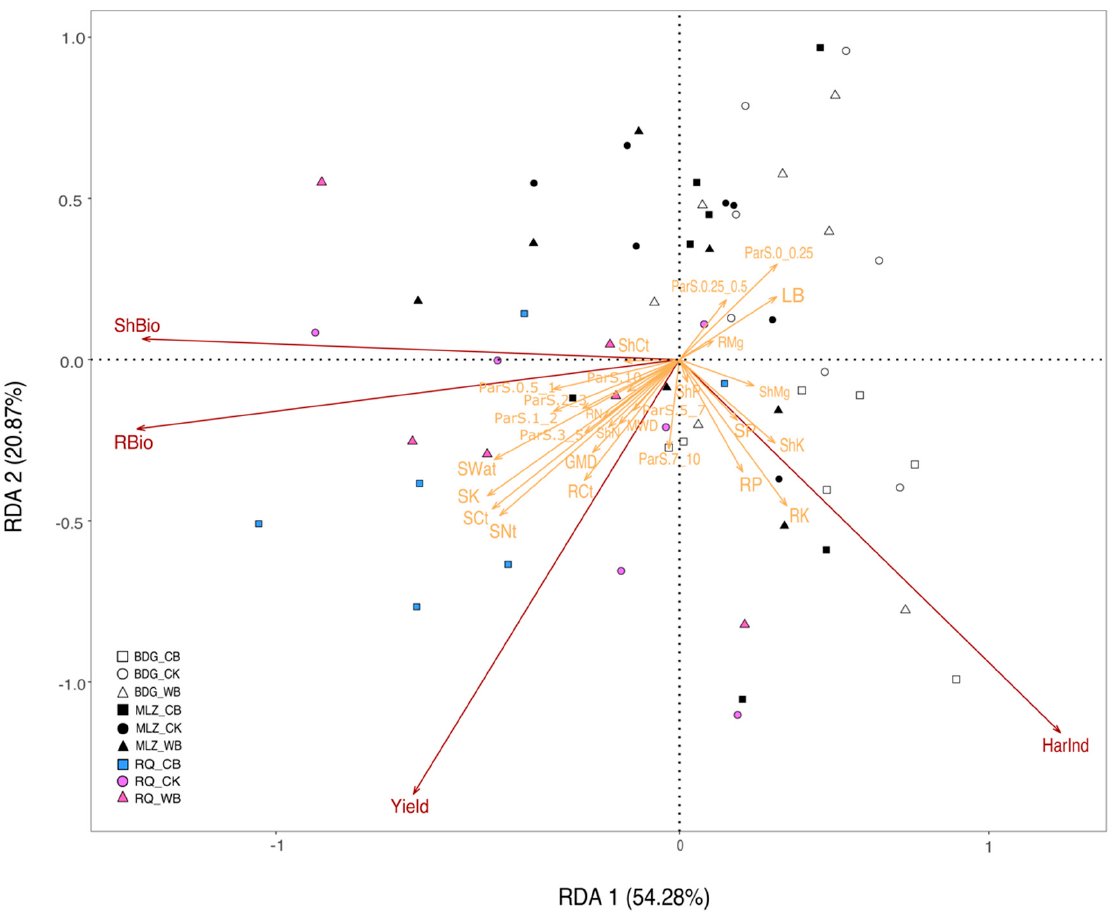
Figure 6. RDA-ordination triplot of variables in sandy clay loam (BDG and MLZ) and silty clay loam (RQ) soils. Response variables are shown in the red vector; explanatory variables are shown in the orange vector. ShBio, shoot biomass; Rbio, root biomass; Yield, grain yield; Harlnd, harvest index; LB, leghemoglobin content; SCt, soil total C content; SNt, soil total N content; SP, soil P content; SK, soil K content; Swat, soil water content; MWD, mean weight diameter; GMD, geometric mean diameter; ParS, particle size; ShCt, shoot C concentration; ShN, shoot N concentration; ShP, shoot P concentration; ShK, shoot K concentration; ShMg, shoot Mg concentration; RCt, root C concentration; RN, root N concentration; RP, root P concentration; RK, root K concentration; RMg, root Mg